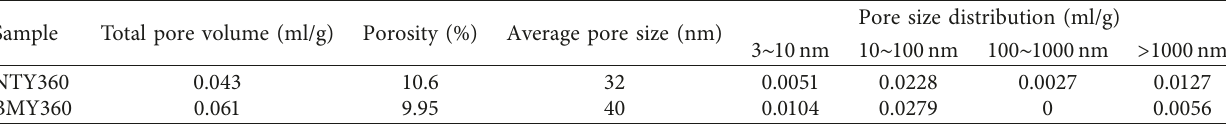
Table 2: MIP results of concrete.